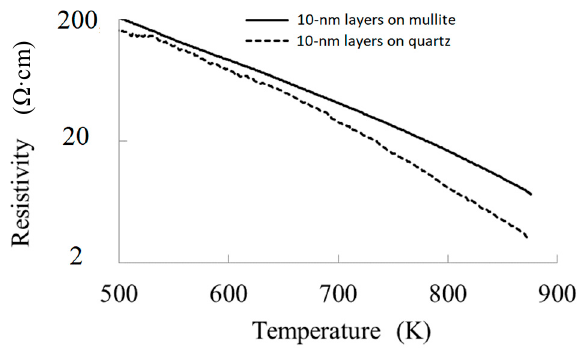
Figure 7. Resistivity of the two candidate substrates as a function of temperature.